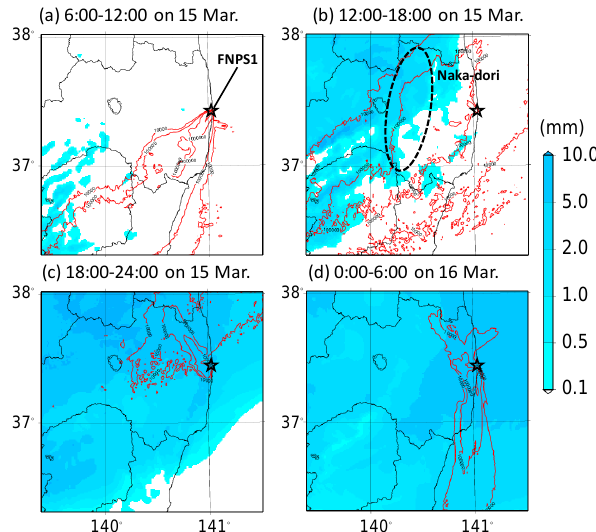
Figure 10. Spatial distributions of the vertical cumulative air con- centration of 137 Cs (Bqm − 3 , red contour lines) and precipitation amount (mm, shaded areas) accumulated at ( (a) 06:00–12:00 on 15 March, (b) 12:00–18:00 on 15 March, (c) 18:00–24:00 on 15 March, and (d) 0:00–6:00 on 16 March calculated by WSPEEDI-II using the new source term. The dashed ellipse in (b) represents the Nakadori area in Fukushima Prefecture (Sect.